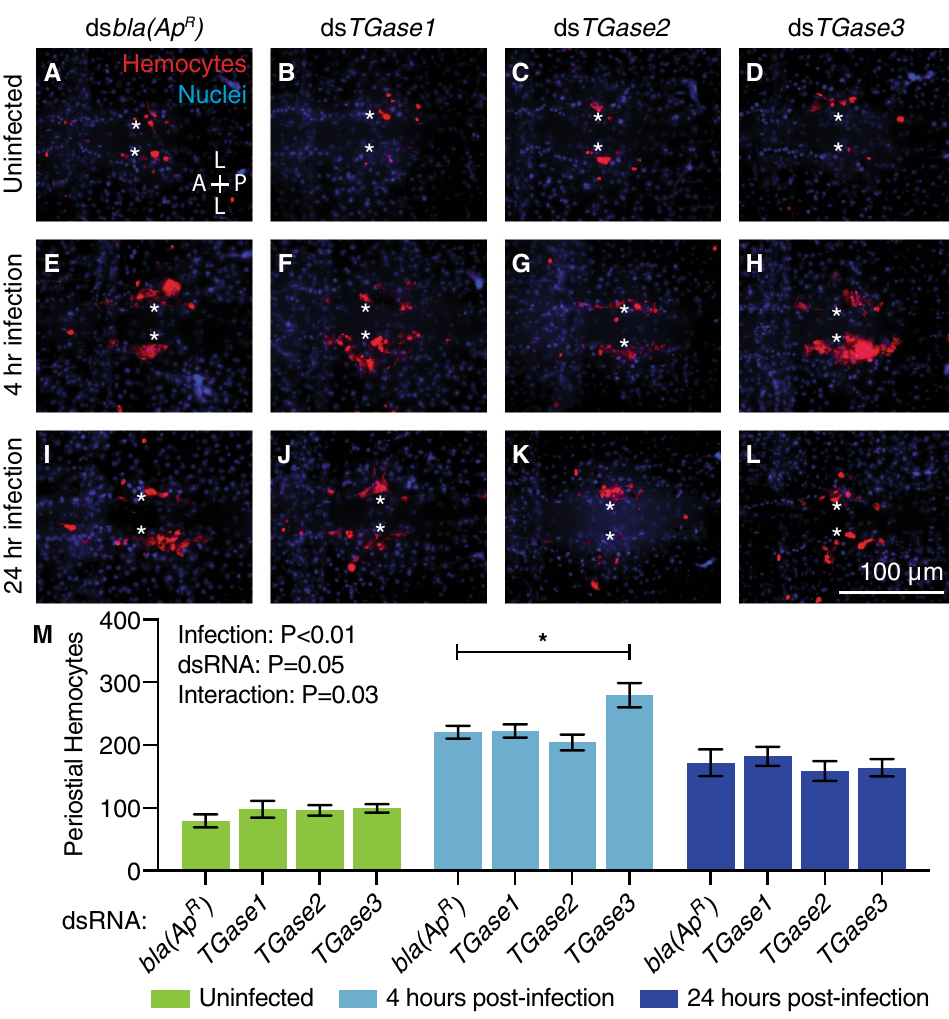
Figure 2. RNAi-based knockdown of TGase3 increases the number of periostial hemocytes during the early stages of GFP- E. coli infection. ( A – L ) Each fluorescence image shows the tergum of a single abdominal segment with periostial hemocytes (CM-DiI; red) surrounding the ostia (asterisks) in uninfected mosquitoes ( A – D ), and mosquitoes at 4 ( E – H ) or 24 h ( I – L ) post-infection. Prior to treatment, mosquitoes had been injected with ds bla(Ap R ) ( A , E , I ), ds TGase1 ( B , F , J ), ds TGase2 ( C , G , K ) or ds TGase3 ( D , H , L ). Nuclei were stained blue with Hoechst 33342. A, anterior; P, posterior; L, lateral. ( M ) Graph shows the average number of periostial hemocytes in ds bla(Ap R )- , ds TGase1- , ds TGase2- and ds TGase3- injected mosquitoes that were uninfected or had been infected with GFP- E. coli for 4 or 24 h. Data were analyzed by two-way ANOVA followed by Dunnett’s post-hoc test, using ds bla(Ap R ) mosquitoes as the reference. Infection P indicates whether infection has an effect irrespective of dsRNA treatment, dsRNA P indicates whether dsRNA treatment has an effect irrespective of infection, and interaction P indicates whether the effect of infection changes with dsRNA treatment. Column heights mark the means, whiskers show the standard error of the mean (S.E.M.), and the asterisk indicates post- hoc P <